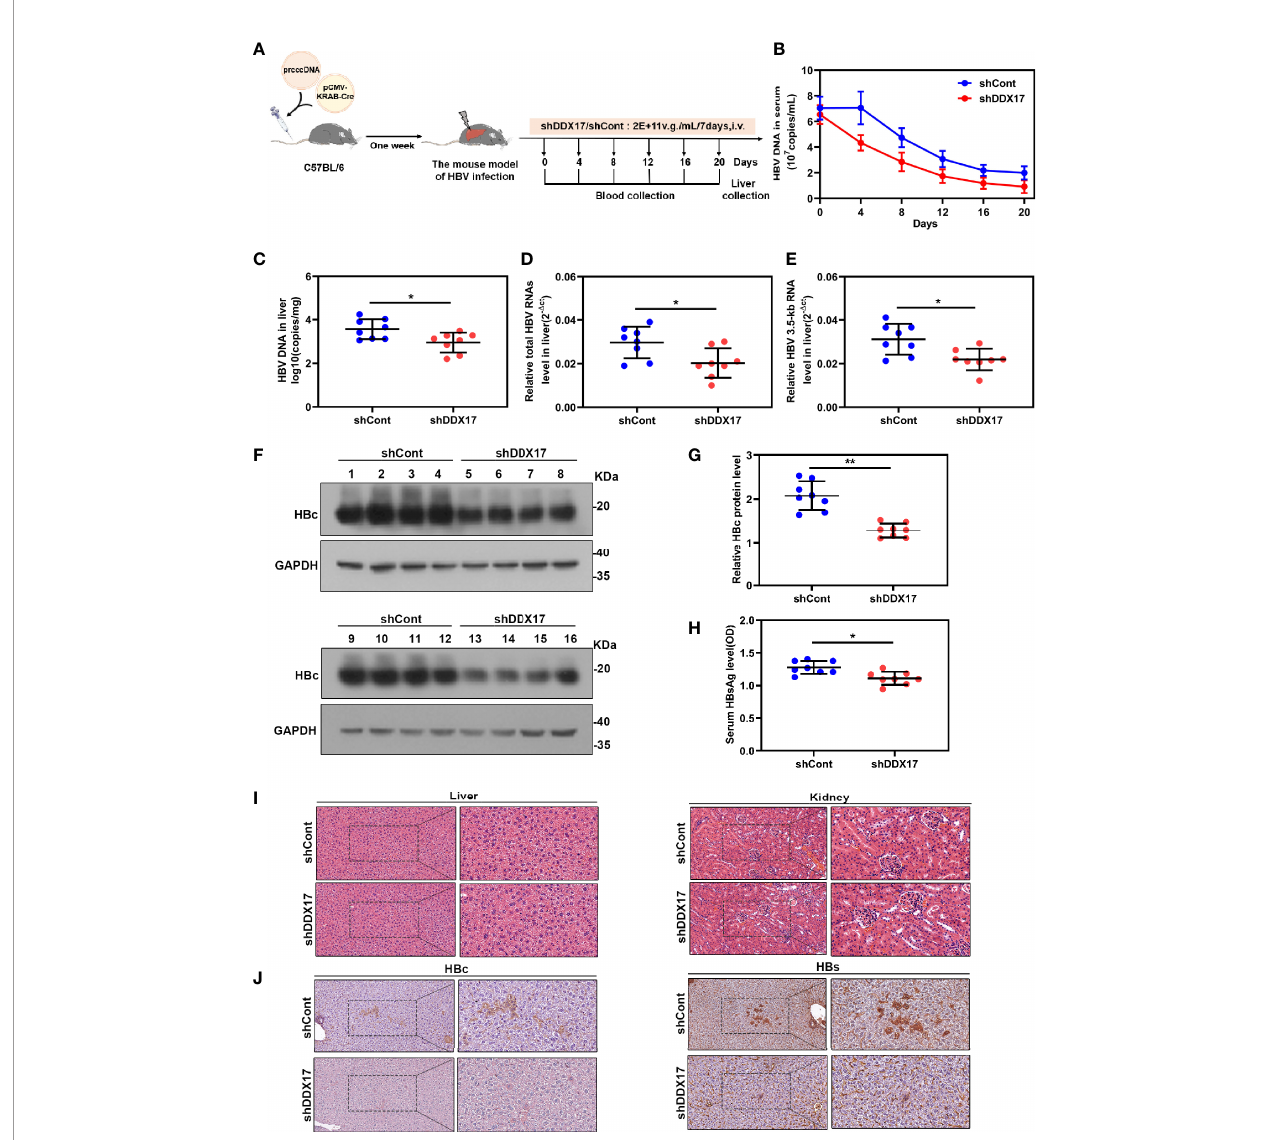
FIGURE 6 | DDX17 promotes HBV transcription and replication in vivo . (A) Flow chart explaining the way and concentration of AAV-shDDX17 administration as well as the intervals of vein blood collection. The mouse model established by injecting prcccDNA and pCMV-KRAB-Cre from tail vein. The mouse model of HBV infection involving HBV recombinant (r) cccDNA constructed successfully were randomly assigned to 2 groups (n = 8 per group). (B) Real-time PCR was subjected to detect the serum level of HBV DNA. (C) Real-time PCR was subjected to detect the level of HBV DNA in liver tissue. (D, E) Real-time PCR was subjected to detect the total HBV RNAs and 3.5-kb RNA levels in liver tissue, b -actin was used as the internal quantitative control. (F, G) The levels of HBc protein were measured by Western blot assay. (H) ELISA assay was subjected to determine the level of HBsAg in serum during the treatment. (I) Abnormal pathological changes in the two groups were determined by HE staining. (J) The expression of HBs and HBc in liver tissues were analyzed by immunohistochemistry. *P < 0.05, **P <